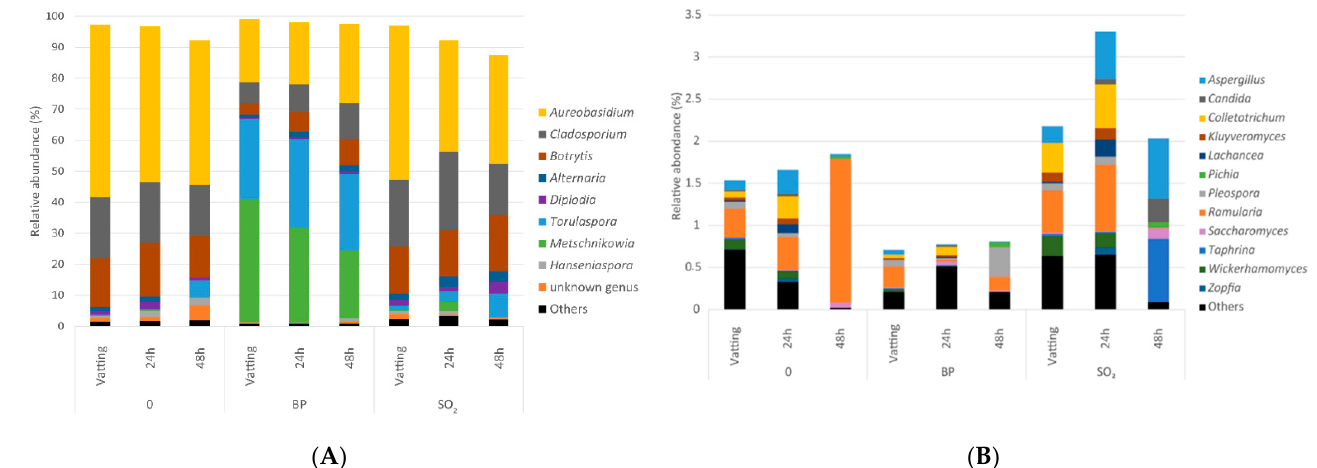
Figure 3. ( A ) Relative genus abundances based on the taxonomic assignation of high-quality 18S rDNA reads of Ascomycota phylum from must samples at prefermentary stages (treatment: without SO 2 (0), SO 2 (SO 2 ), bioprotection (BP); stages: vatting, 24 h prefermentary maceration, 48 h prefermentary maceration). ( B ) Relative genus abundances in “Others” category for each sample. (Mean of biological replicates).